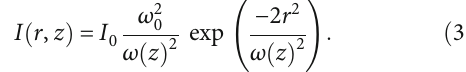
Figure 3: Simpli fi ed schematics of a 3DLL fabrication setup employing an ampli fi ed fs laser and harmonic generator. PP G : Brewster angle polarizers; M: mirrors; RM: removable mirror; RPM: removable power meter; T: telescope; Obj: objective. Adapted with 2 permission from [6] © The Optical